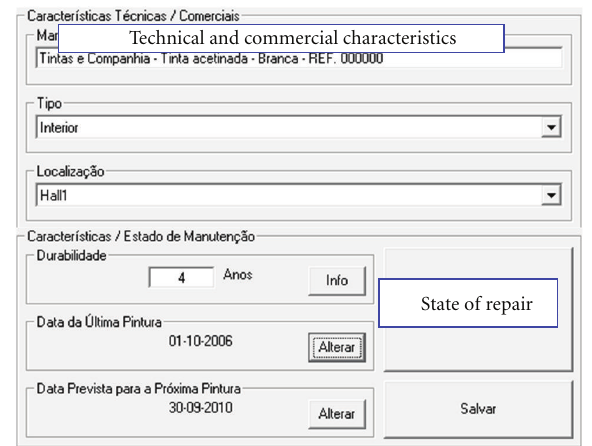
Figure 7: Technical characteristics and the durability of the paint-work.